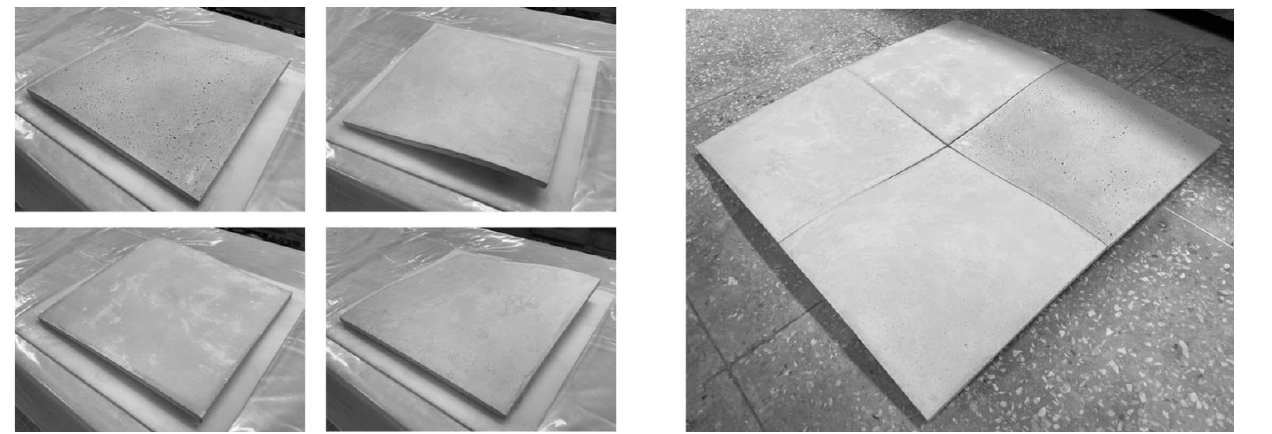
Figure 14. Final free-form concrete